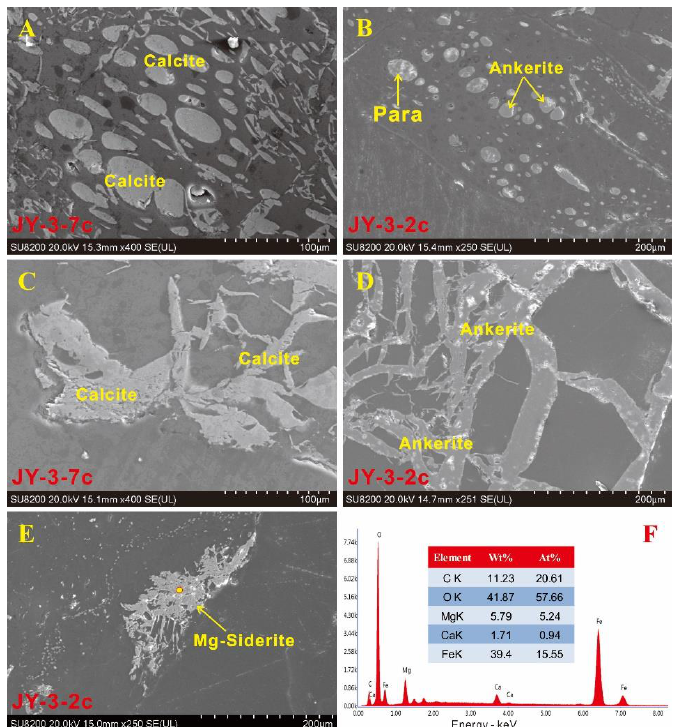
Figure 6. SEM secondary electronic and reflected light optical microscope images of Quartz (Qua) in the JY-3 Coal. ( A , B ), detrital quartz and cell-filling quartz; ( C , D ), authigenic quartz.